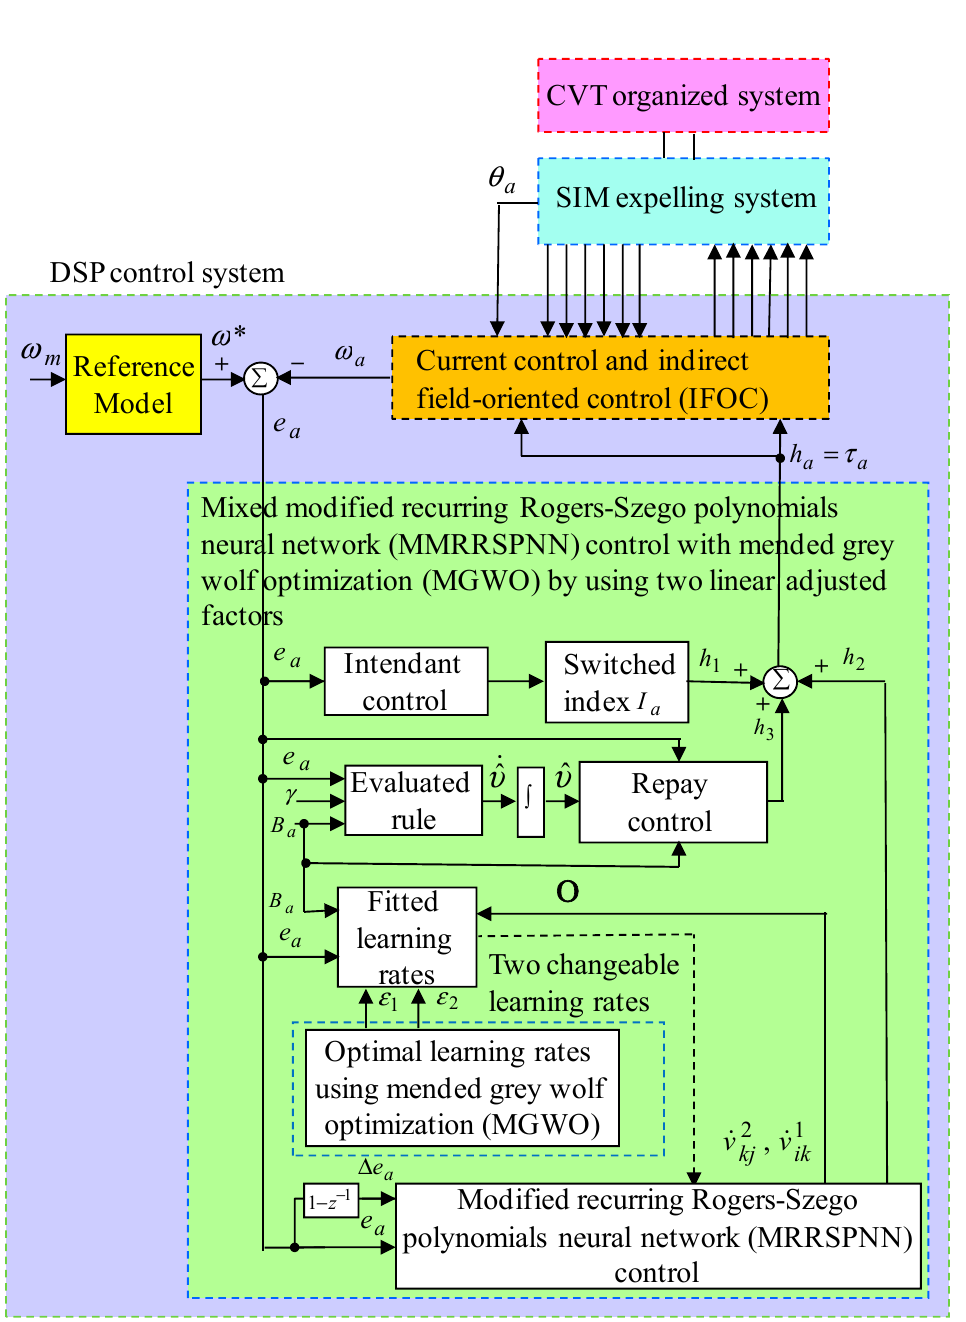
Figure 3. Block diagram of the MMRRSPNN control with MGWO by using two linear adjusted factors.